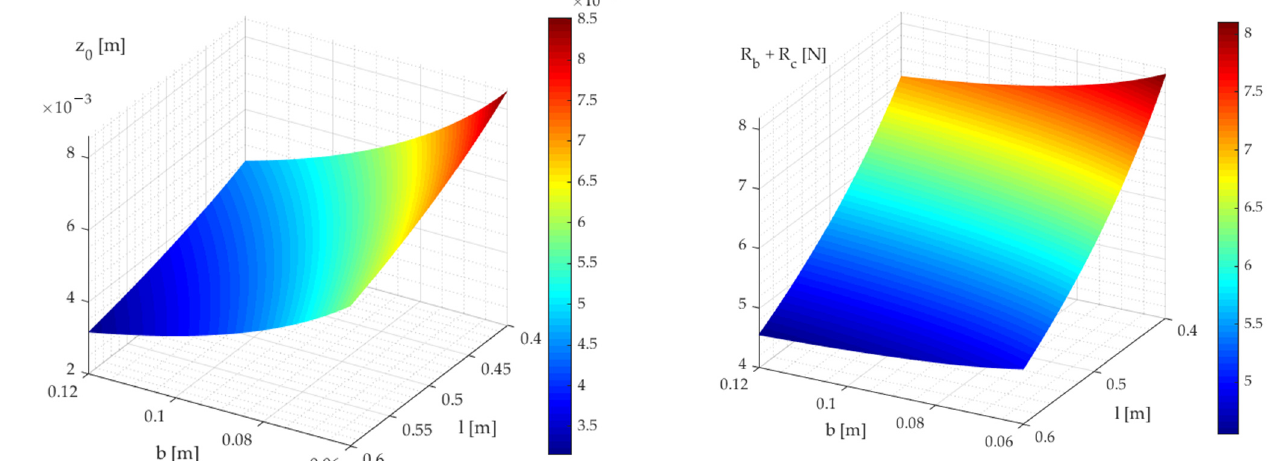
Figure 9. Track sinkage ( z 0 , ( left ) [m]) and sum of compaction and bulldozing resistances ( R b + R c , ( right ) [N]) as function of the track width b [m] and length l [m].